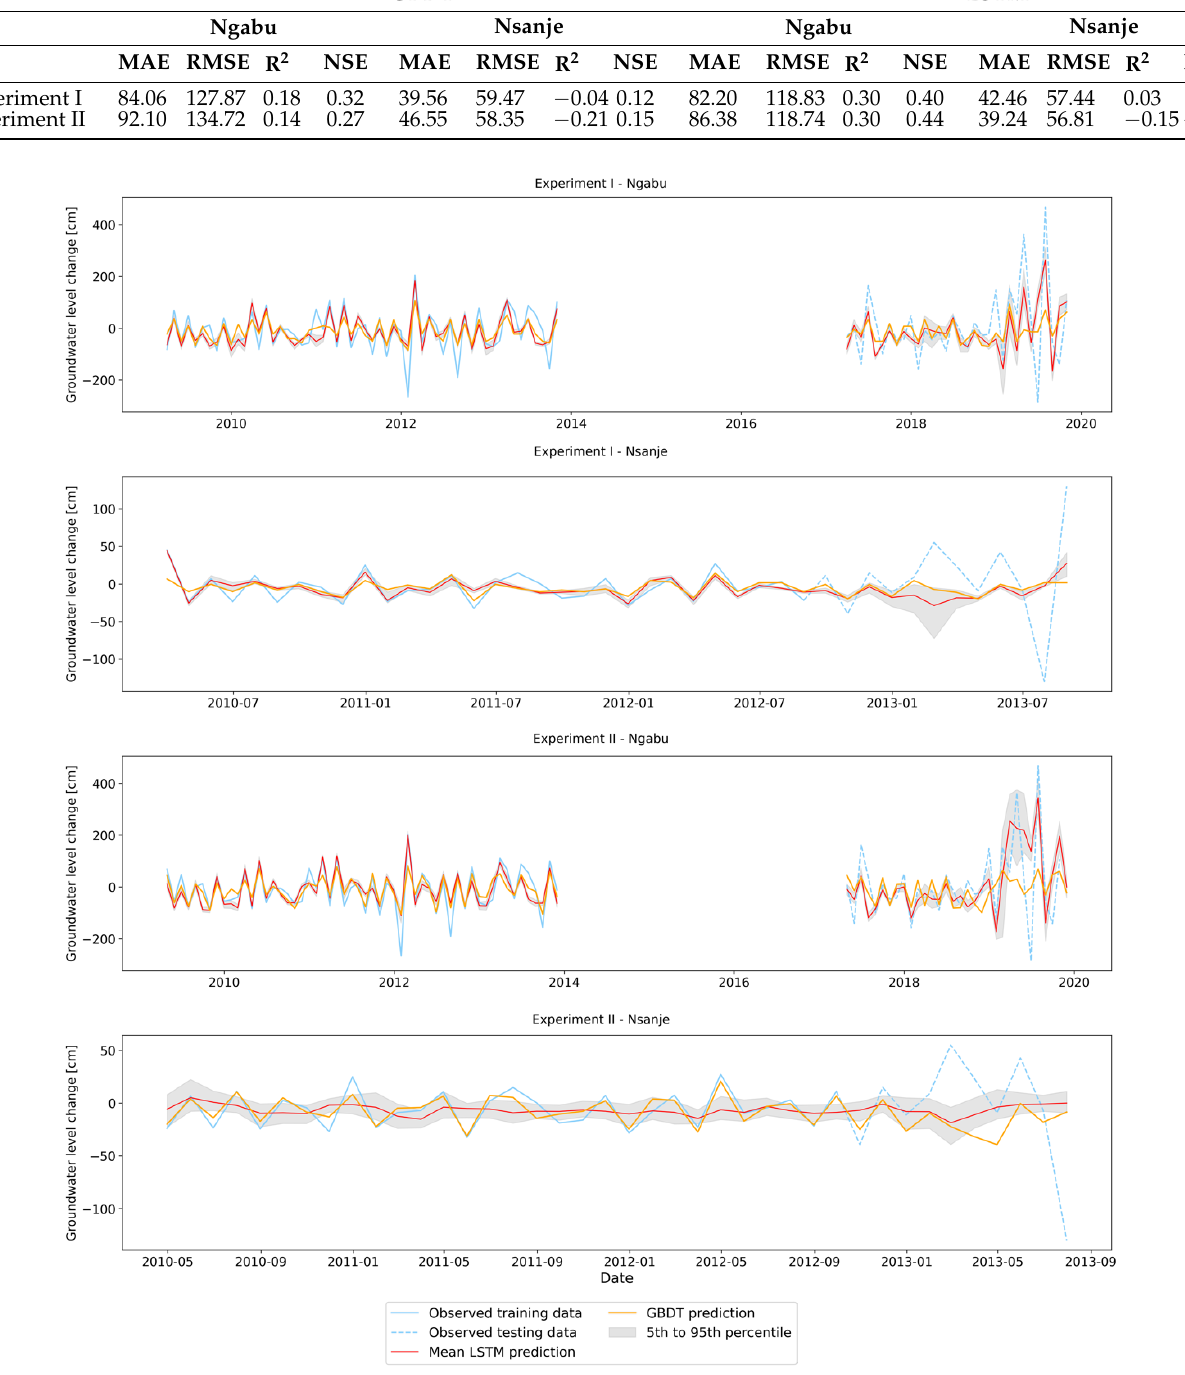
Figure 10. Hydrographs of the predicted vs. observed groundwater level changes for each experi- Hydrographs of the predicted vs. observed groundwater level changes for ment. each